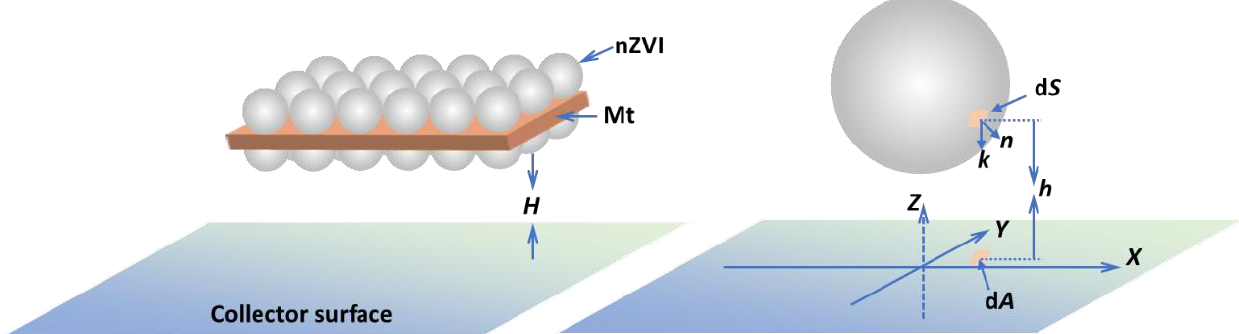
Figure 1. Schematic to illustrate interaction between a modeled Mt-nZVI heteroaggregate or a spherical nZVI particle and collector surface. H is separation distance between the heteroaggregate and the surface, d S is differential area element on the nZVI particle surface, d A is the projected area of d S on the planar surface, h is local distance between the area element d S from the collector surface (i.e., the distance between the d S and d A ), n is unit outward normal to the particle surface, and k is unit vector normal along the negative z-direction.